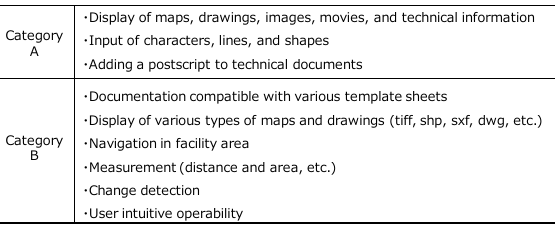
Table 1. Functions and performance of infrastructure inspection